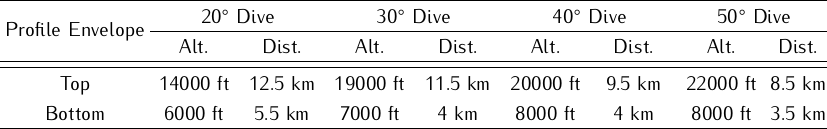
Table 21. Flight profiles envelopes for propagation flight trials.